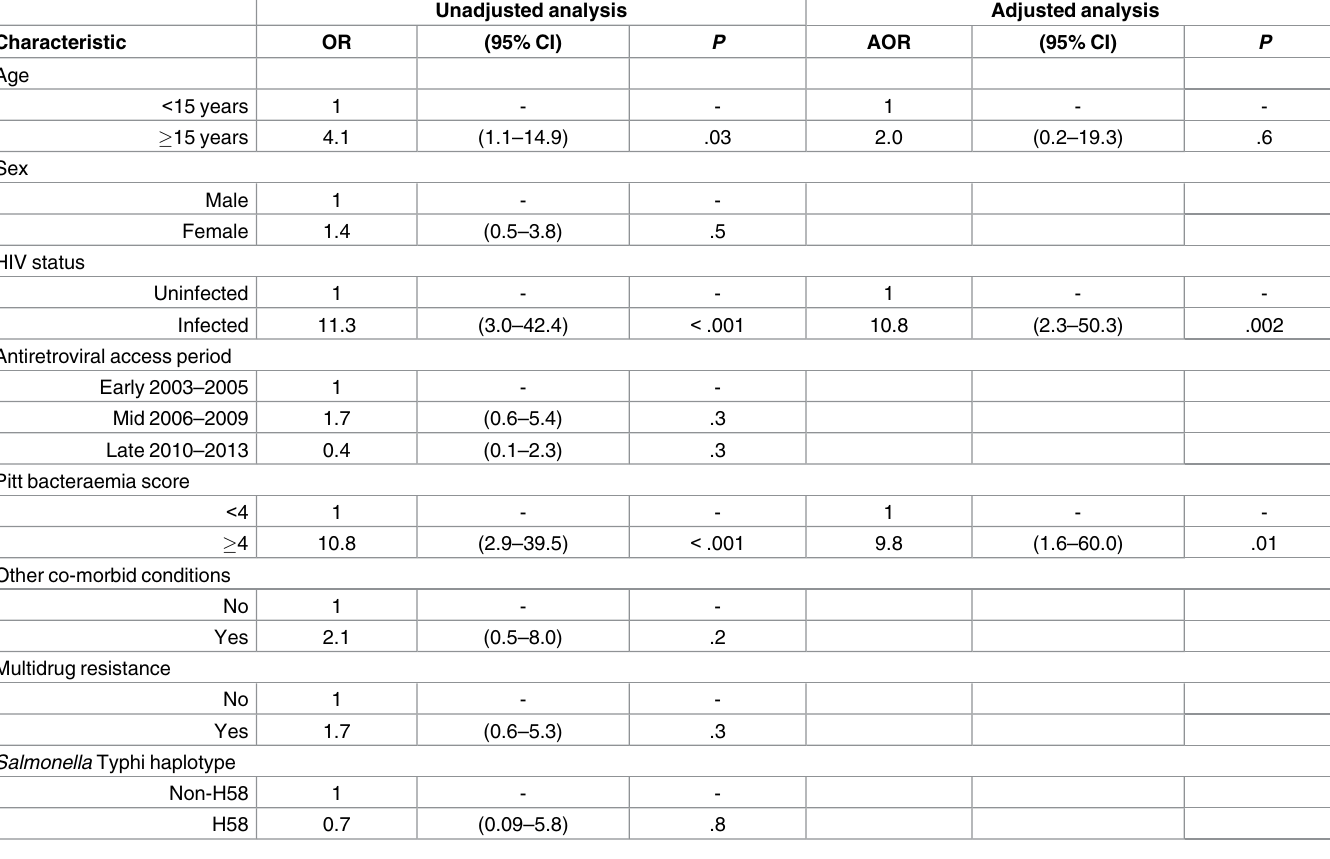
Table 3. Univariate and multivariate analysis of risk factors associated with mortality in patients with Salmonella Typhi in South Africa, 2003–